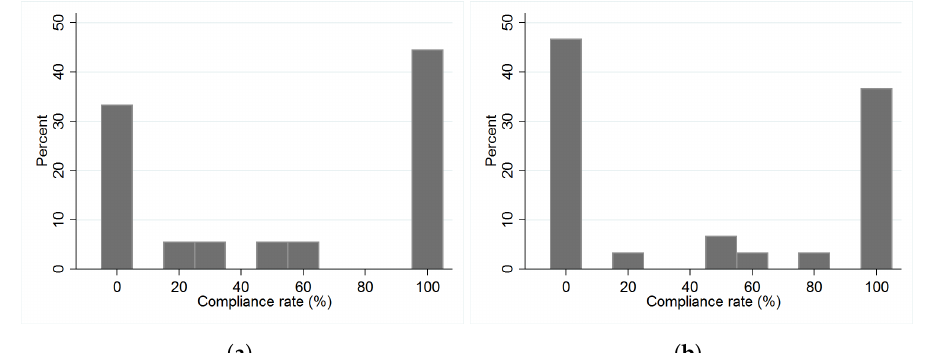
Figure A1. Distribution of low-income taxpayers’ compliance choices by treatment (groups of three). Only the compliance choice distributions for uninformed low-income taxpayers are displayed. These distributions do not differ significantly between performance-based and random allocation (Mann-Whitney U test: p = 0.478, Kolmogorov-Smirnov test: p = 0.988). There were no or few observations with informed low-income taxpayers in groups of three (two groups or six observations under the random allocation (RA) condition, zero observations under the performance-based allocation (PBA)). ( a ) PBA, without information (N = 18); ( b ) RA, without information (N = 30).